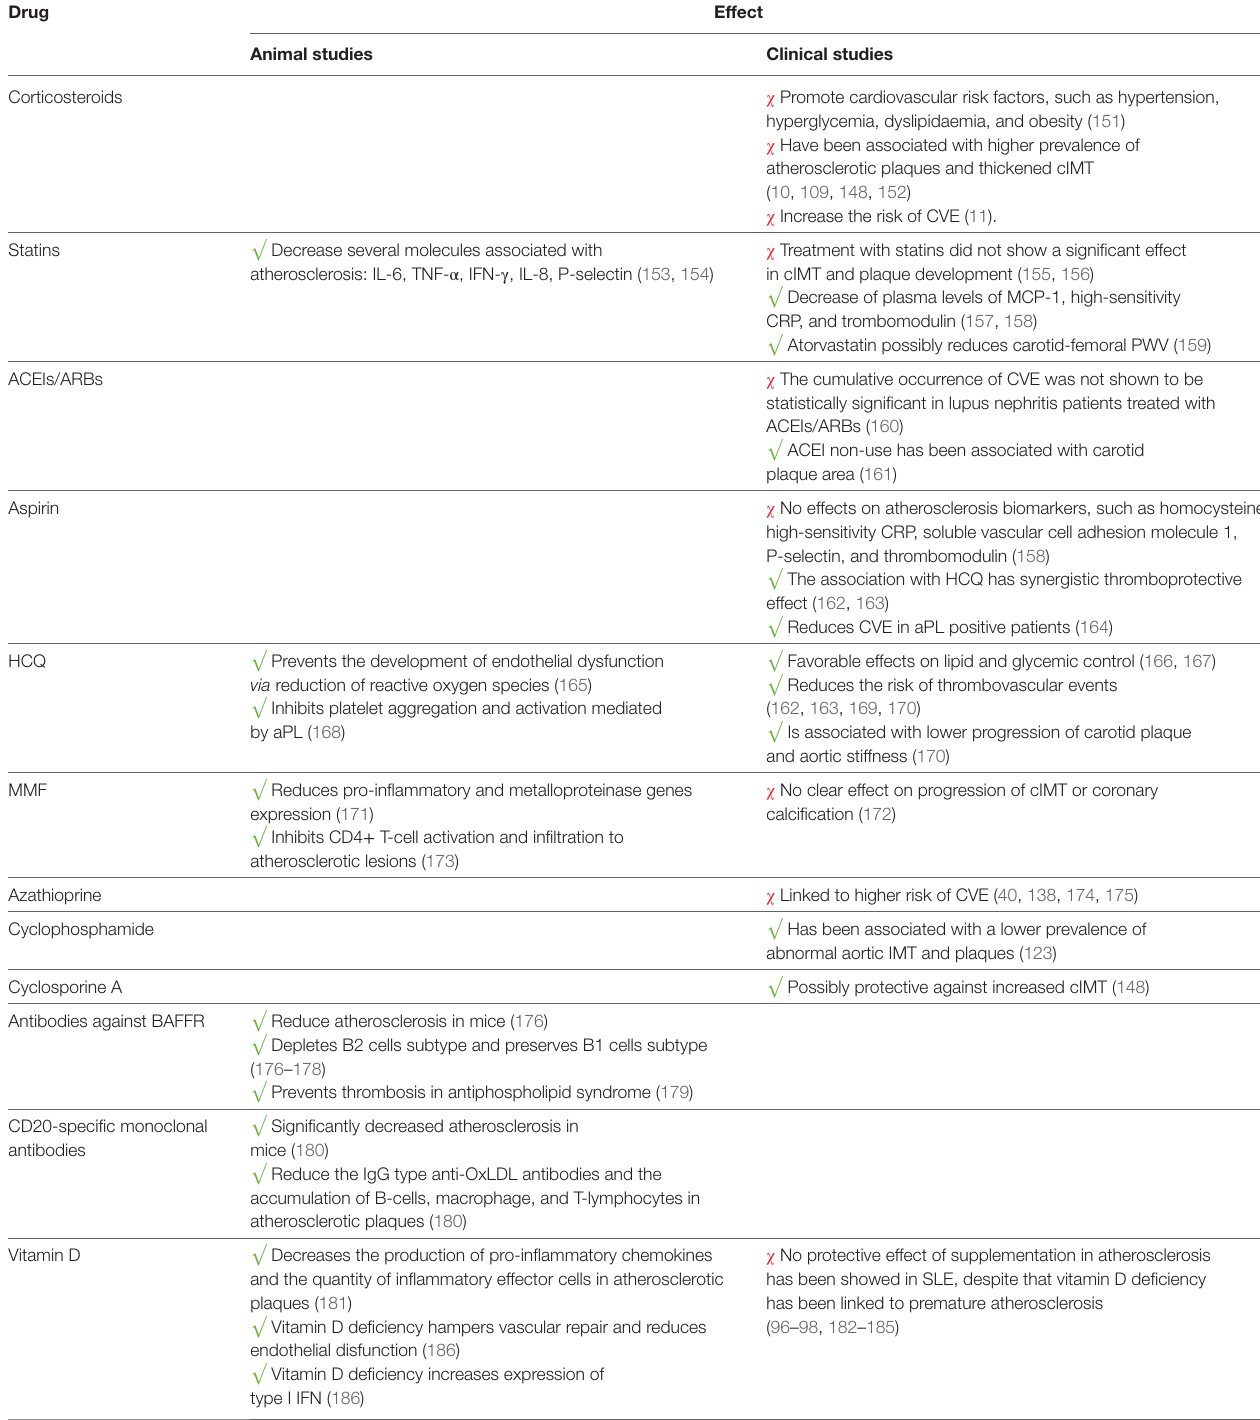
TABLe 3 | Summary of the effects of several drugs on atherosclerosis and CVE in